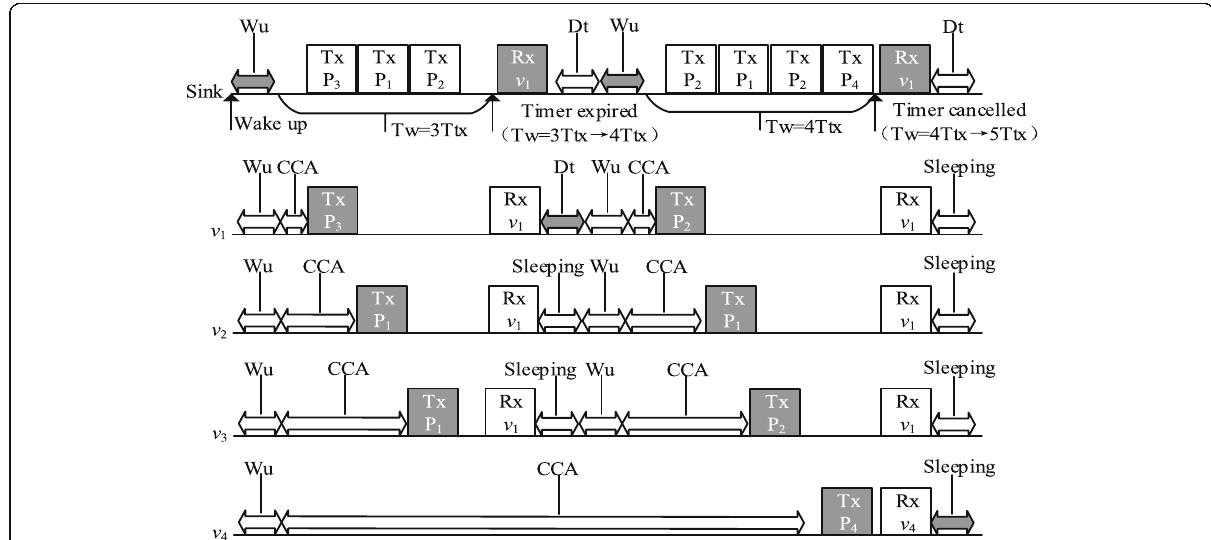
Fig. 9 In network 2, the initial wait time is T w = 3 T x during transmission under the DWT-MAC